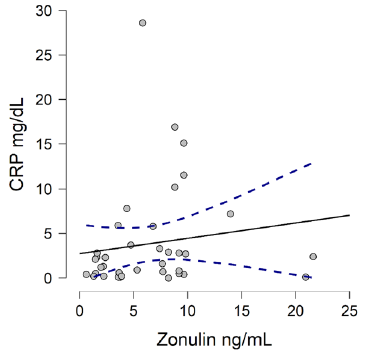
Figure 4. Correlation plot between Zonulin and C-reactive protein for infected